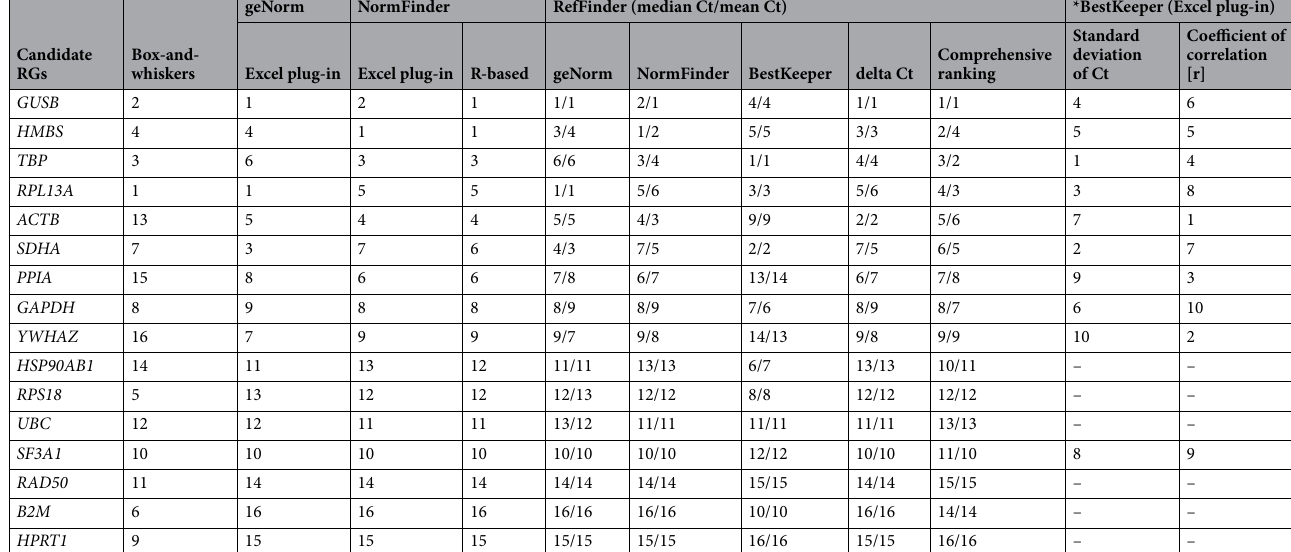
Table 5. Compilation of rankings of candidate RGs by all statistical tools and algorithms. *The six genes most frequently ranked with the lowest stability were omitted from analysis using BestKeeper, which is limited to evaluating only 10